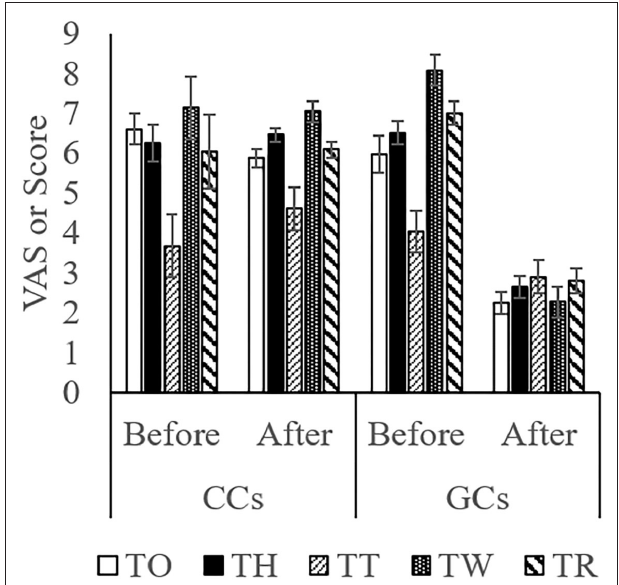
FIGURE 3 | Temperament during handling in GCs and CCs. The horizontal axis shows the temperament before and after the start of grazing. Data are presented as the means ± SEM. TO, The VAS score for overall movement; TH, The visual analog scale (VAS) score for head movement; TT, The VAS score for tail flicking; TW, The VAS score for walking/stepping; TR, The VAS score for rope